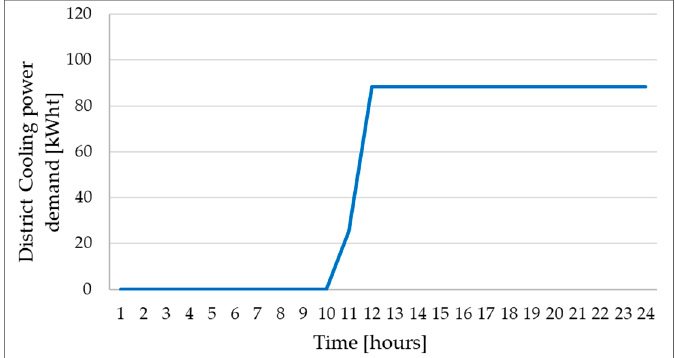
Figure 6. Total daily district cooling power demand in the reference case.